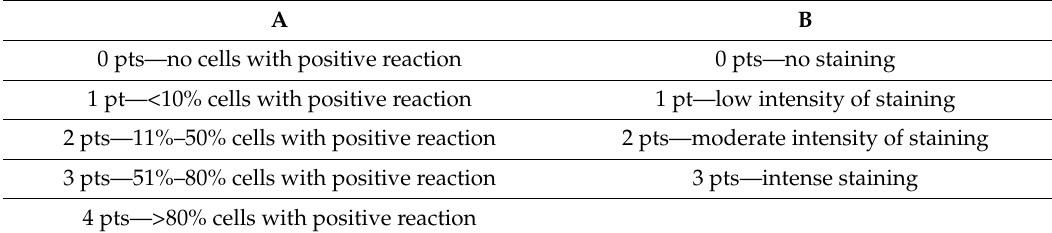
Table 5. Remmele and Stegner score: the percentage of positive cells (A) and the intensity of color reaction (B). The final score represents the result of these parameters (A ×